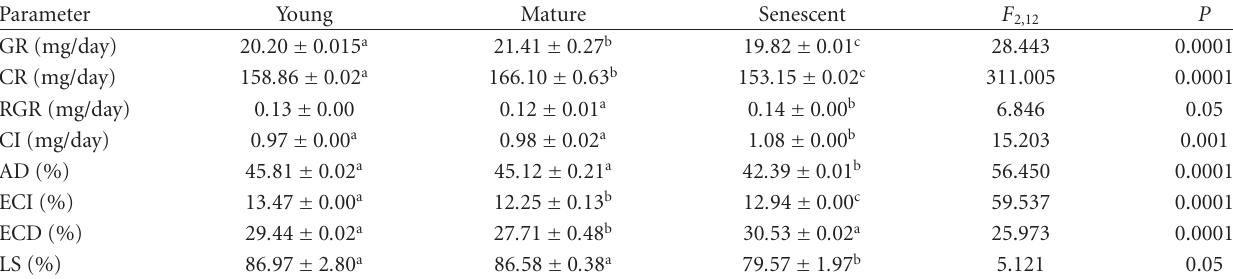
Table 7: Food utilization e ffi ciency measures of sixth instar larva of D. casignetum reared on young, mature, and senescent sunflower leaves. Parameter